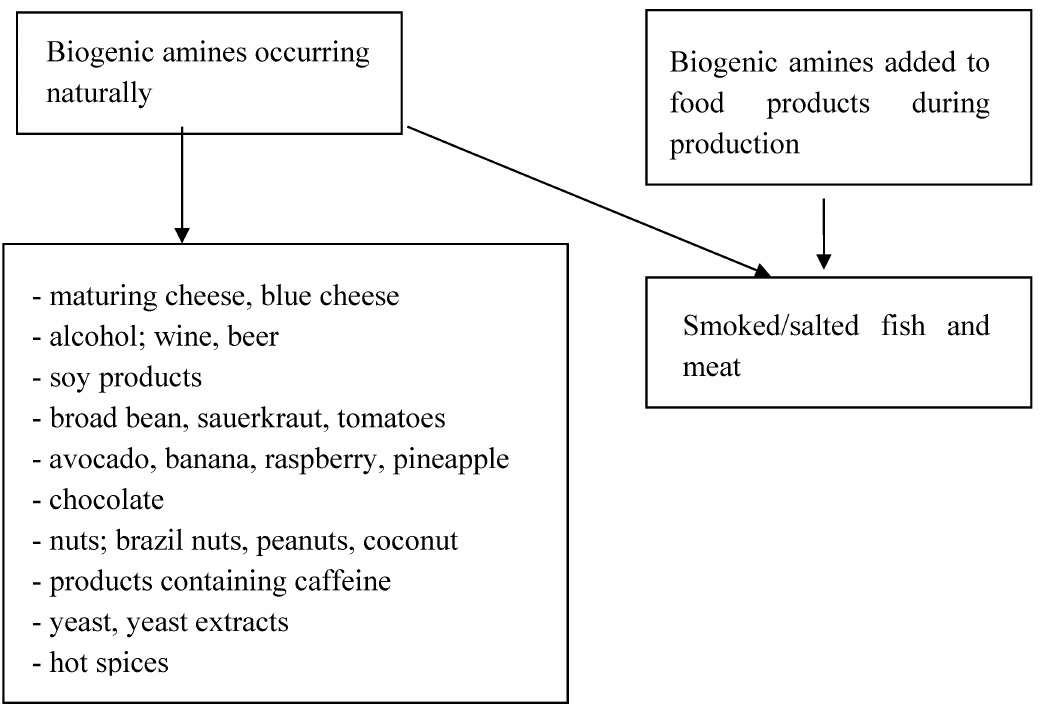
Figure 1. Presence of amines in food products.